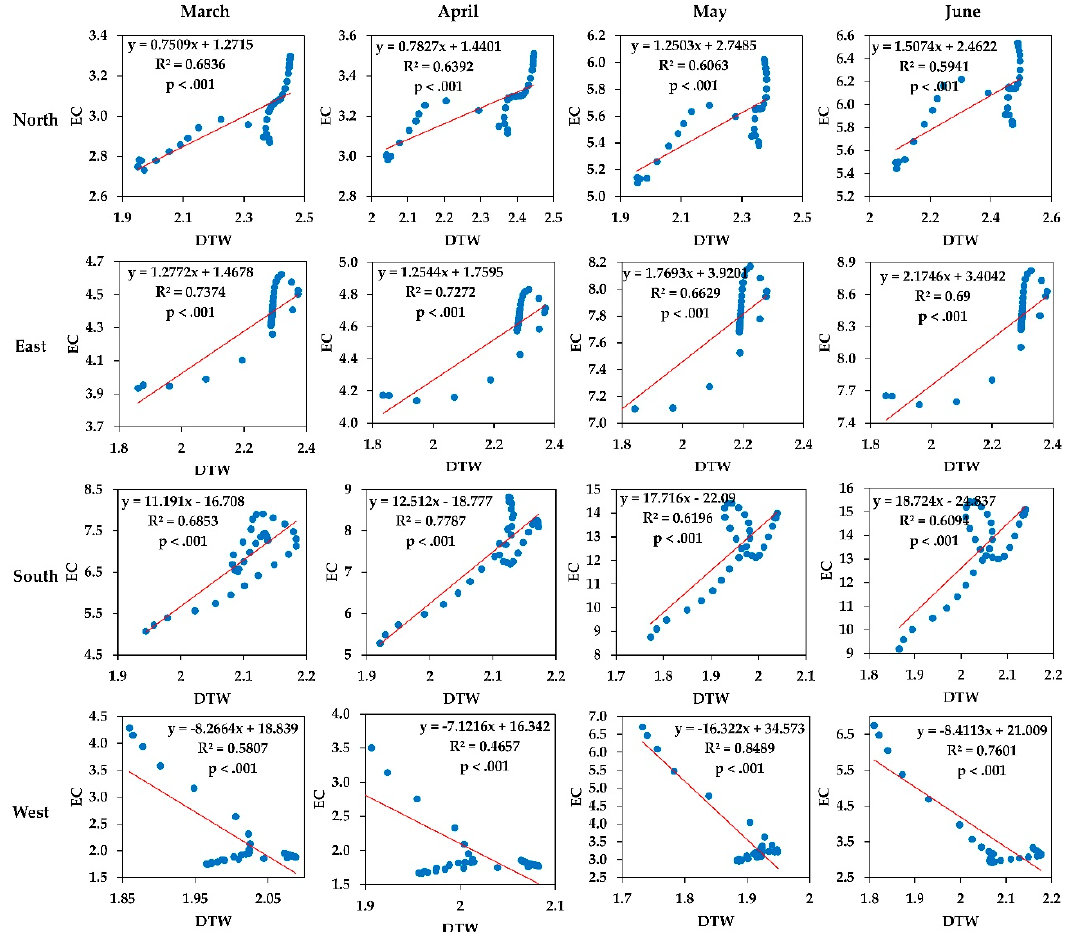
Figure 10. Scatter plots between electrical conductivity and depth to water in March, April, May, and June.